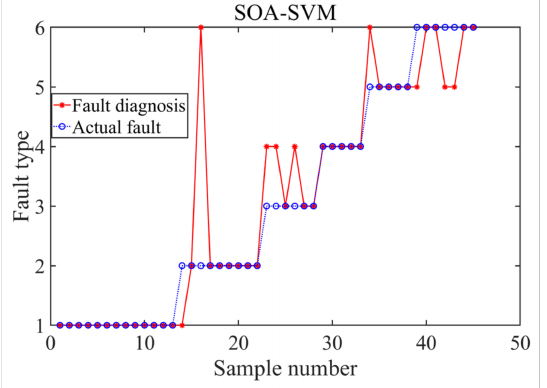
Figure 8. Diagnosis results.